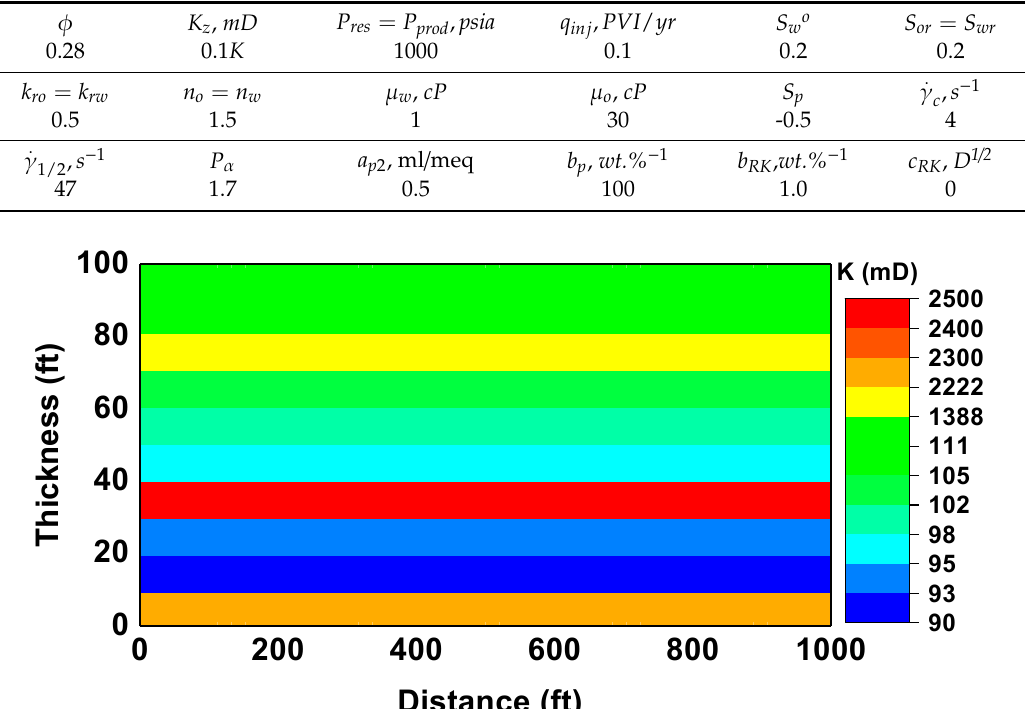
Table 2. Additional parameters kept constant for all polymer flooding and waterflooding simulations.